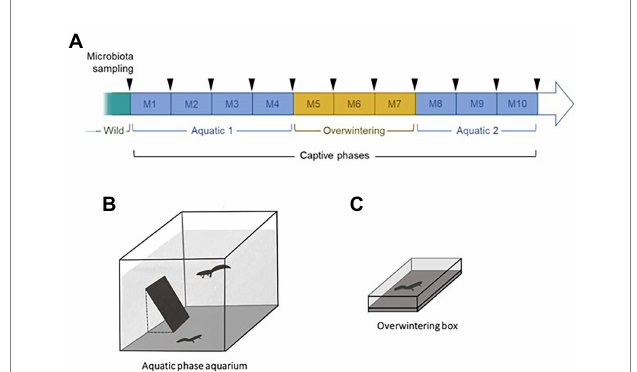
FIGURE 1 Schematic summary of the experimental plan used in this study (A) . Typical management protocols for survival assurance populations were used to maintain the collection of newts, combining biosecurity protocols, restricted social groups, and cycles of active and overwintering phases. Upon capture in the wild, 40 newts (20 per species) were placed by pairs in aquatic aquaria for 4 months without mixing species (Aquatic 1: M1 to M4; B ). They were then transferred in individual containers containing wet cork and placed at 4 ° C to induce a terrestrial overwintering phase for 3 months (Overwintering: M5 to M7; C ). The same pairs of newts as in the first aquatic phase were reunited in a second aquatic phase for 3 months (Aquatic 2: M8 to M10). The skin microbiota of the newts was sampled monthly